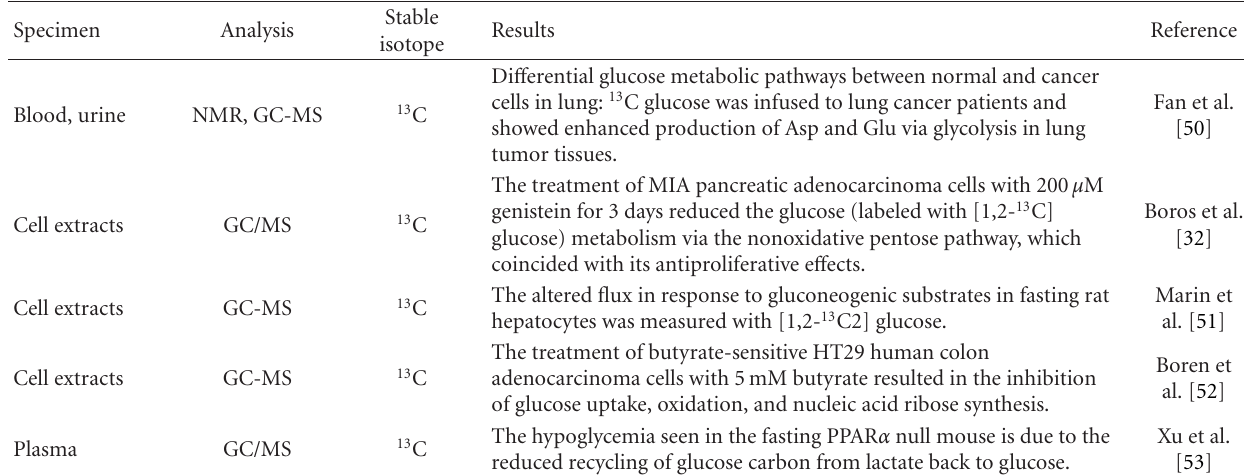
Table 1: Preclinical and clinical nutrition studies using stable-isotope metabonomics.